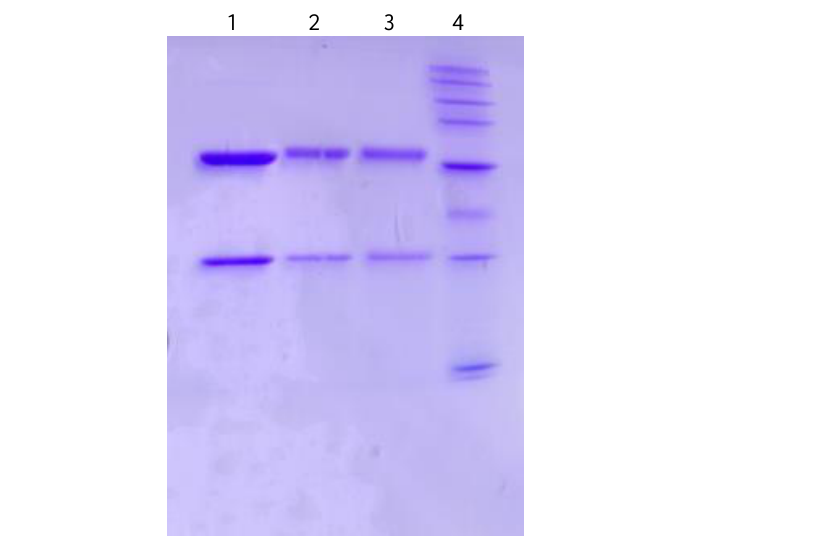
Figure 3. SDS-PAGE of 153 Sm-DOTA- avastin performed in nonreducing condition showing Ladder (lane 4) native mAb (lane 3), conjugated (lane 2), and labelled (lane